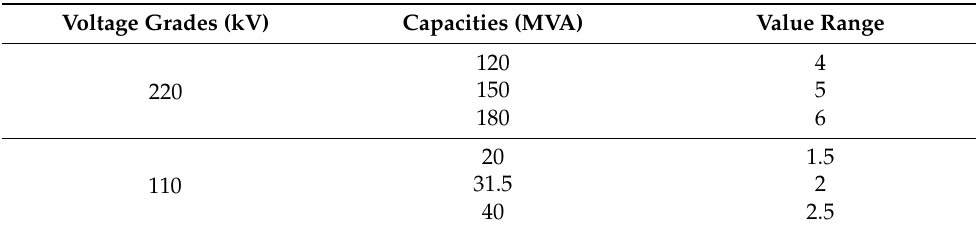
Table 2. Different voltage grades and capacities corresponding to the reference value of equipment importance